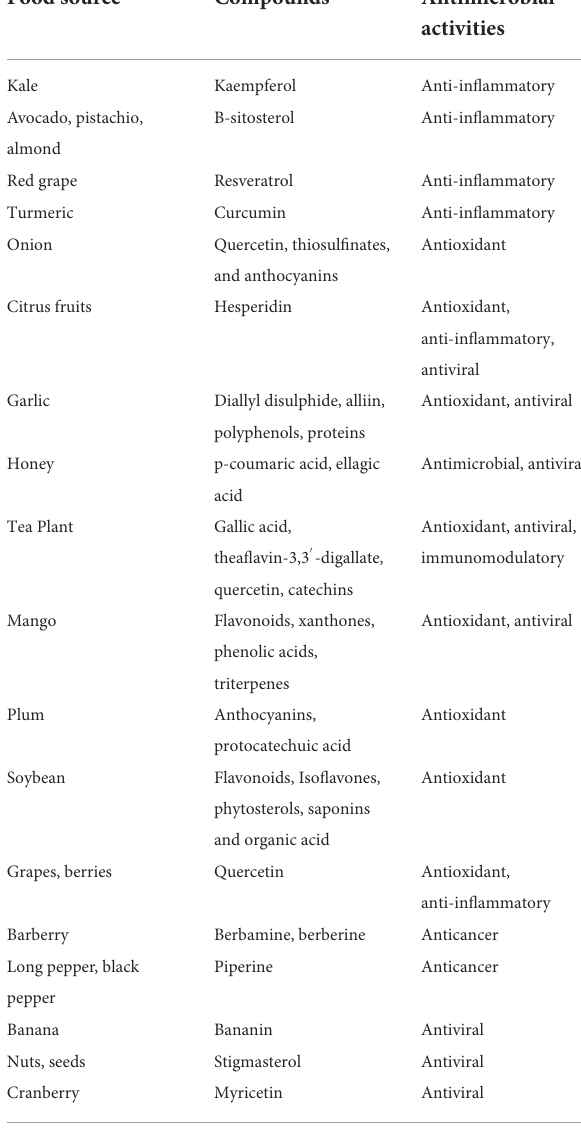
TABLE 3 Antimicrobial activities of foods bioactive